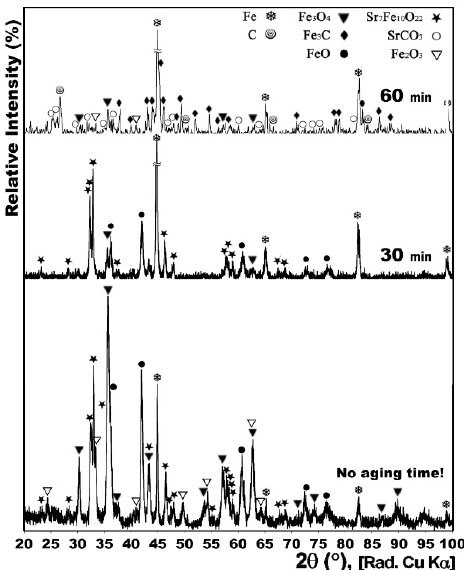
Figure 3. XRD patterns of conventionally synthesized Sr ‐ hexaferrite powders heat treated under dynamic CH 4 flow of 15 cc/min at 950 °C for 0, 30 and 60 min.